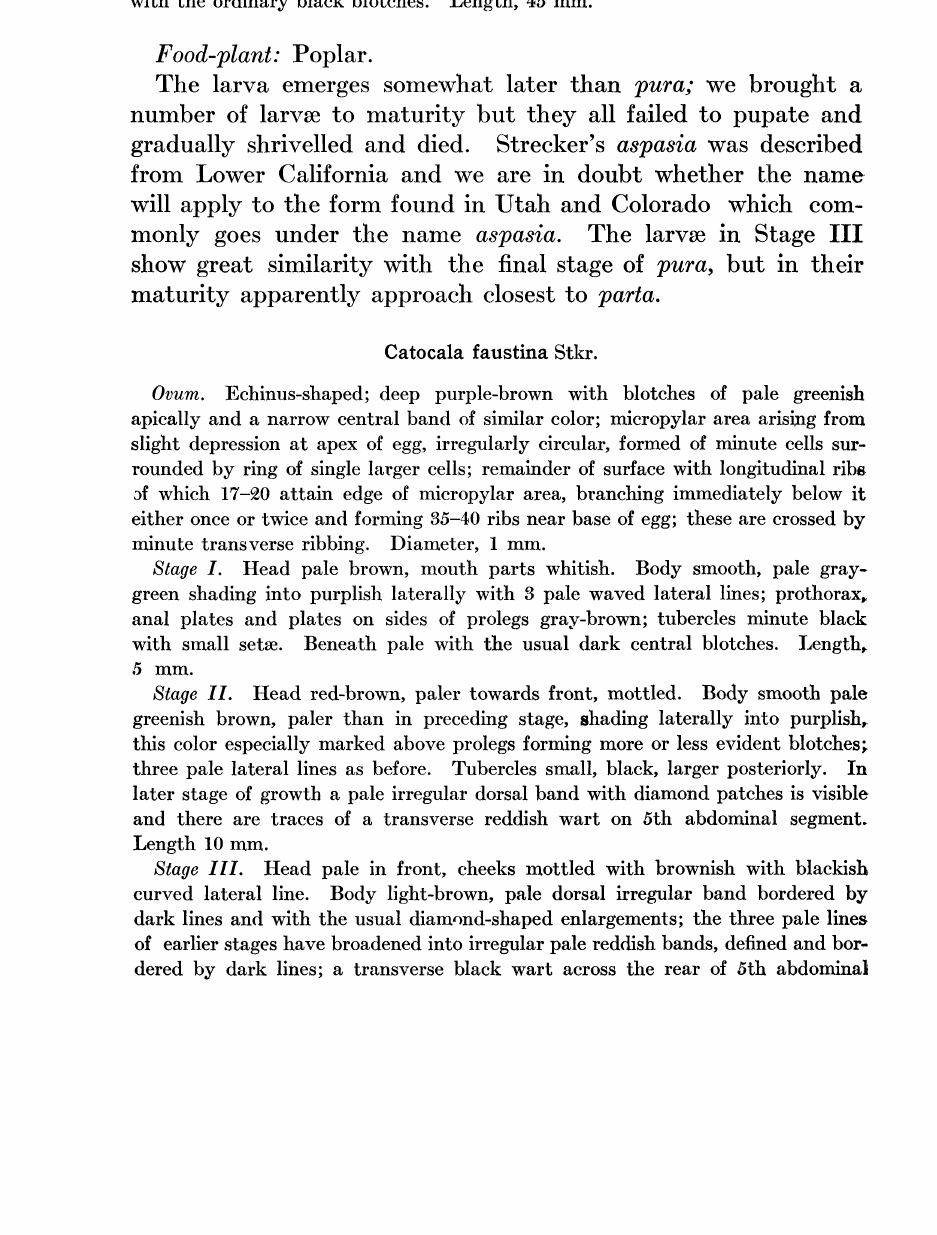
colored dots, usually with subdorsal blackish band formed of numerous spota defining the pale diamond shaped patches, most accentuated behind tubercle II; a similar but less distinct spiracular band; tubercles yellow-c.chre, small; wart on 5th abdominal segment not prominent, tinged vith ochreous; vague traces of a black dorsal lunate mark on 8th abdominal segment; tubercle II on this segment not much larger than on preceding segment; legs and prolegs pale tinged with pinkish; spiracles ochreous ringed with black, filaments pale. Beneath whitish with the ordinary black blotches. Length, 45